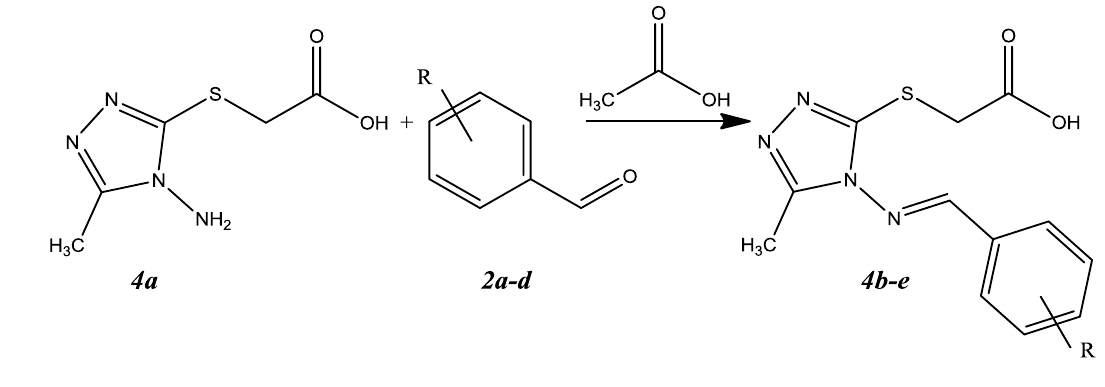
Fig. 3. Scheme of synthesis of 2-((4- (R-arylideneamino) -5-methyl-4H-1,2,4-triazol-3-yl) thio) acetate acids ( 4b-e )